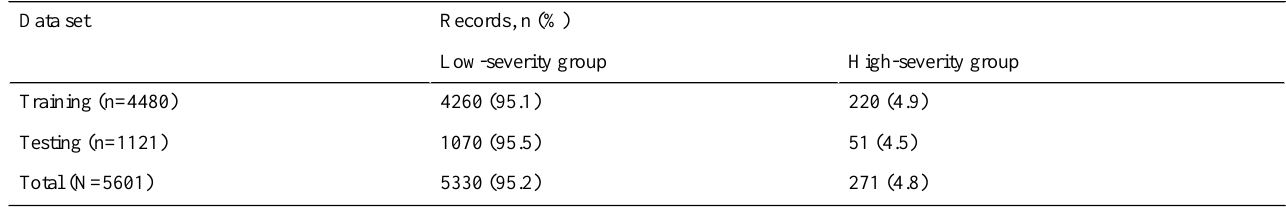
Table 3. Summary of training and testing data